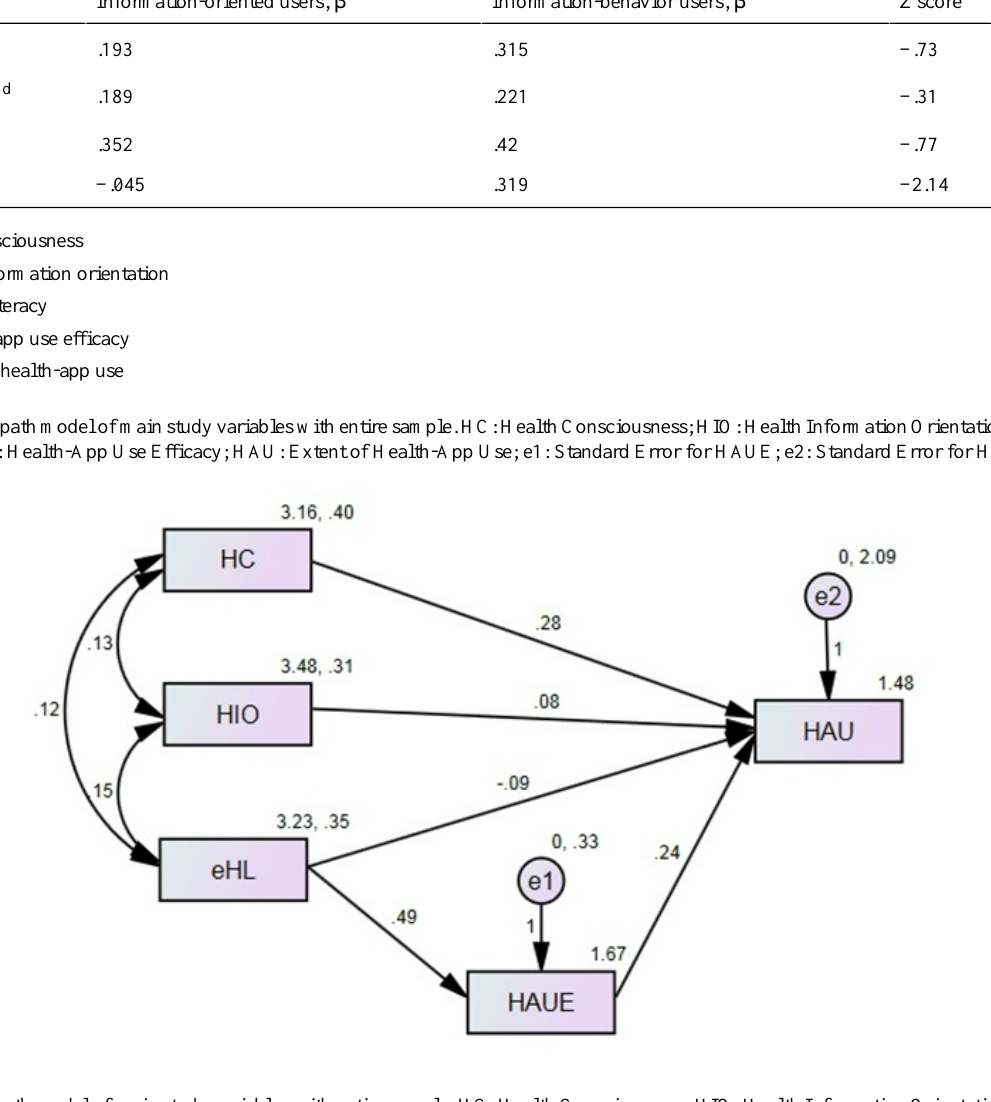
Figure 2. Final path model of main study variables with entire sample. HC: Health Consciousness; HIO: Health Information Orientation; eHL: eHealth Literacy; HAUE: Health-App Use Efficacy; HAU: Extent of Health-App Use; e1: Standard Error for HAUE; e2: Standard Error for